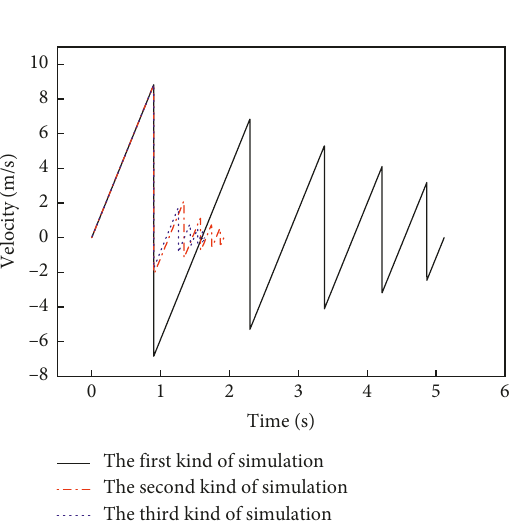
Figure 11: Contact force.